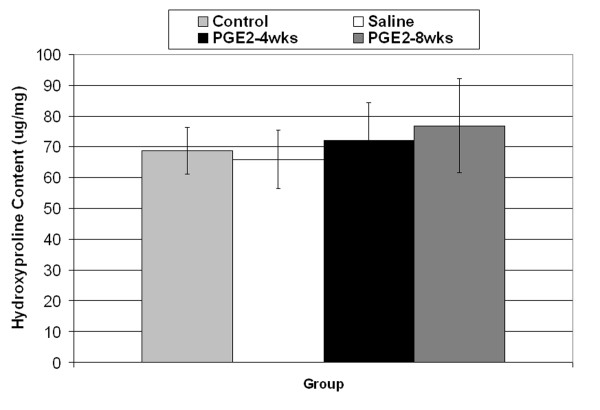
Collagen content of the rat patellar tendon tissue did not differ among the 4 groups (P > 0.05).